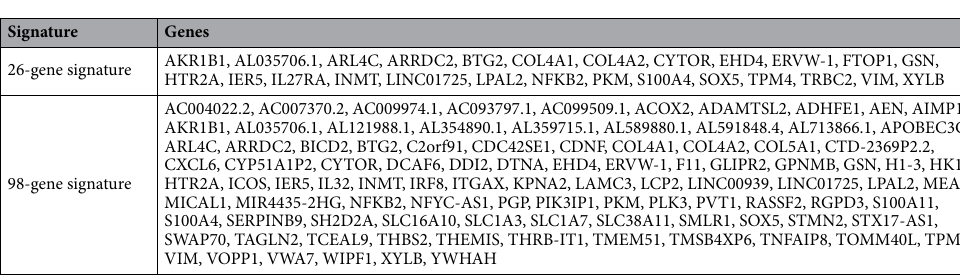
Table 2. Candidate fibrosis